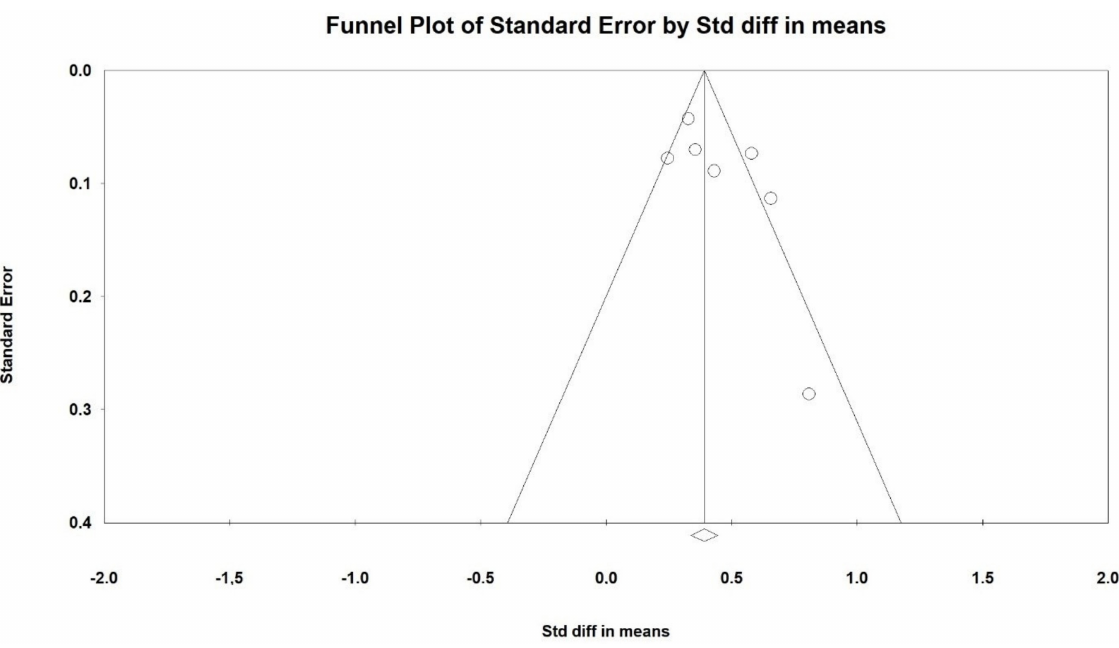
Figure 4. Funnel plot for GOS (DM) in present meta-analysis.